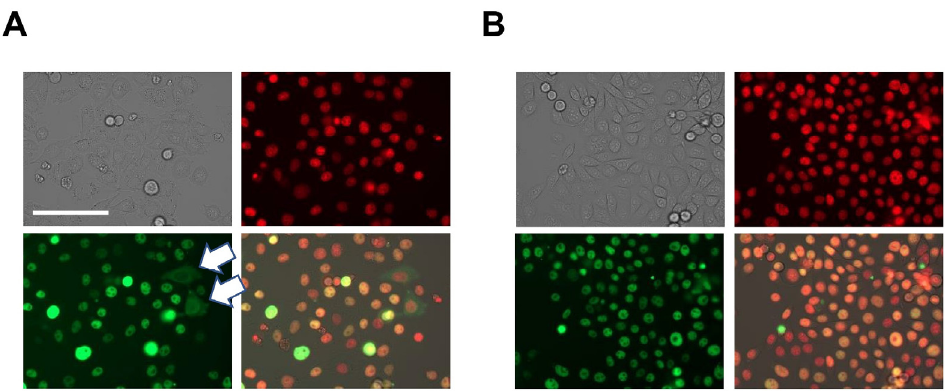
Figure 1. Selection of a fluorescent c-MYC reporter clone. HeLa cells were stably transduced with a lentiviral vector encoding the ZsGreen1-c-MYC fusion protein. The top left panels show brightfield, top right show nuclear counterstain, bottom left visualize ZsGreen1-c-MYC, and bottom right show the merged images. ( A ) The polyclonal population showed differences in expression levels of the fluorescent c-MYC protein. Several cells displayed extranuclear or even exclusive cytosolic expression of the fluorophore (white arrows). ( B ) Expansion of the cell clone used in this study with consistent nuclear expression of the fluorescent c-MYC fusion protein. Magnification was equal in both panels (20 × ), size bar represents 100 µ m. Shown in red is the nuclear counterstain. Additional information is available in Figure S1.